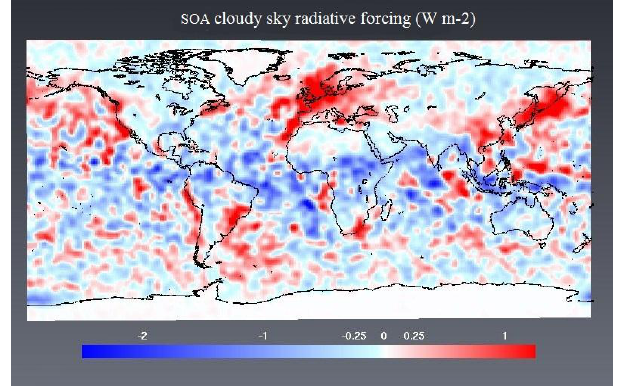
Fig. 11. Annual mean SOA indirect effect. Figure 11. Annual mean SOA indirect effect